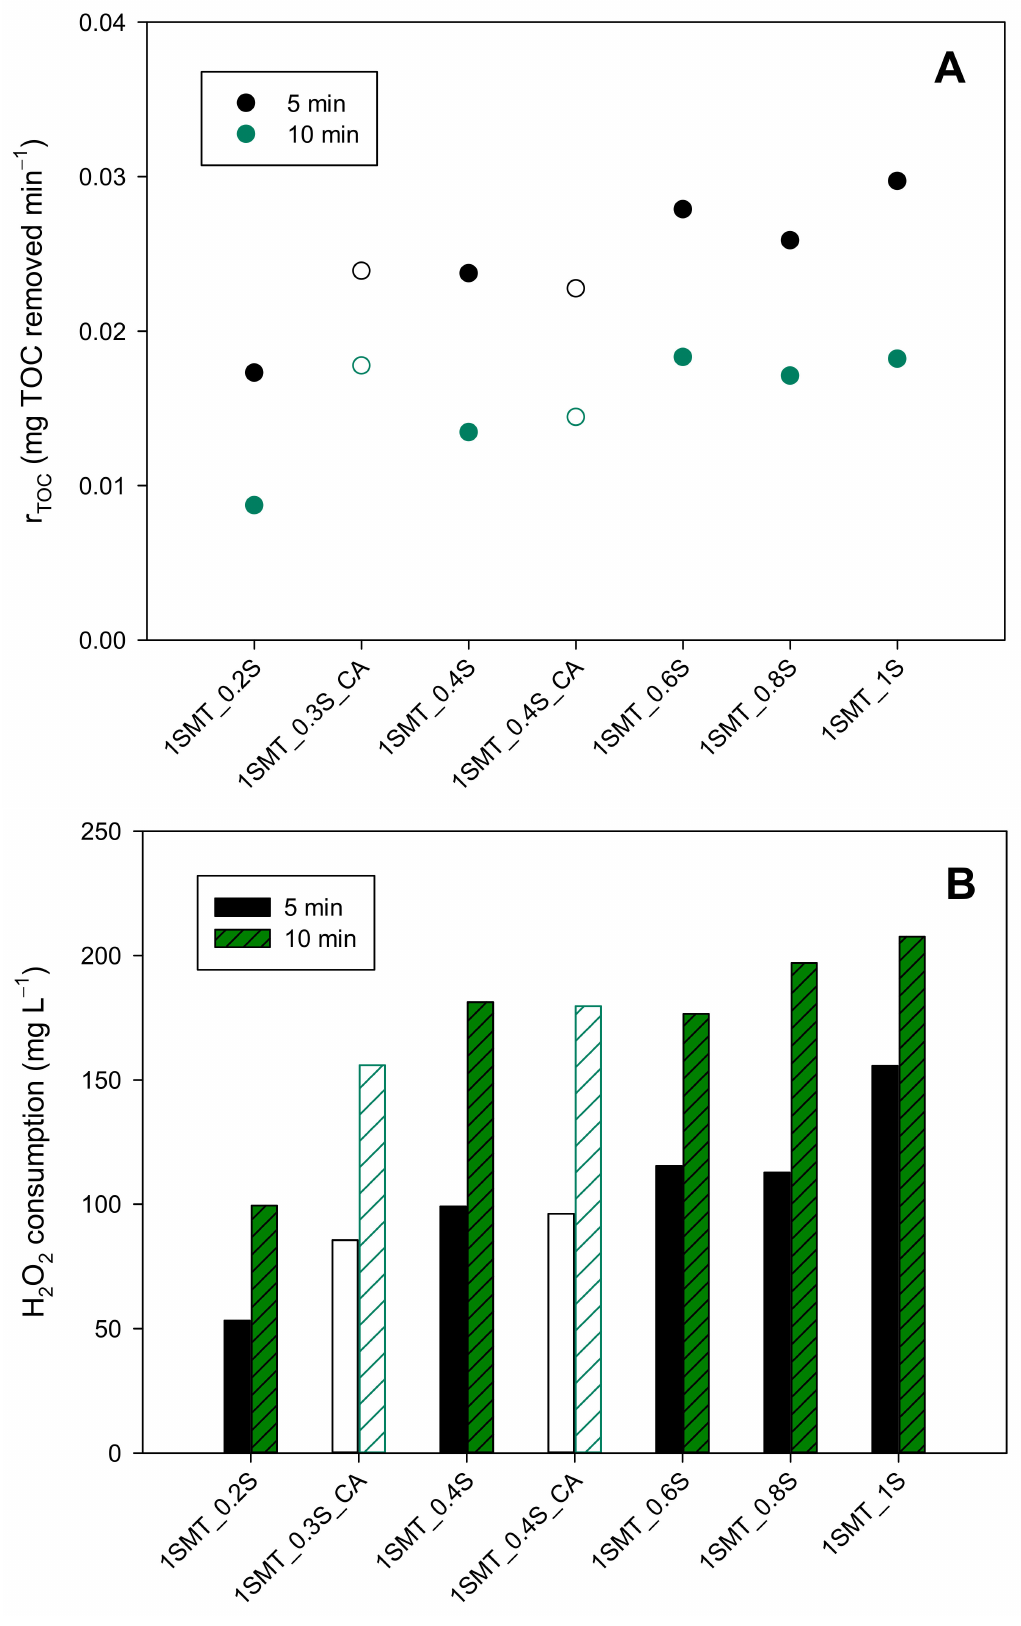
Figure 5. Mineralization rates ( A ) and H 2 O 2 consumption ( B ) after 5 and 10 min of reaction time obtained for the treatment of SMT contaminated water under different initial H 2 O 2 addition profiles (closed symbols: one-shot additions, open symbols: one-shot addition + continuous